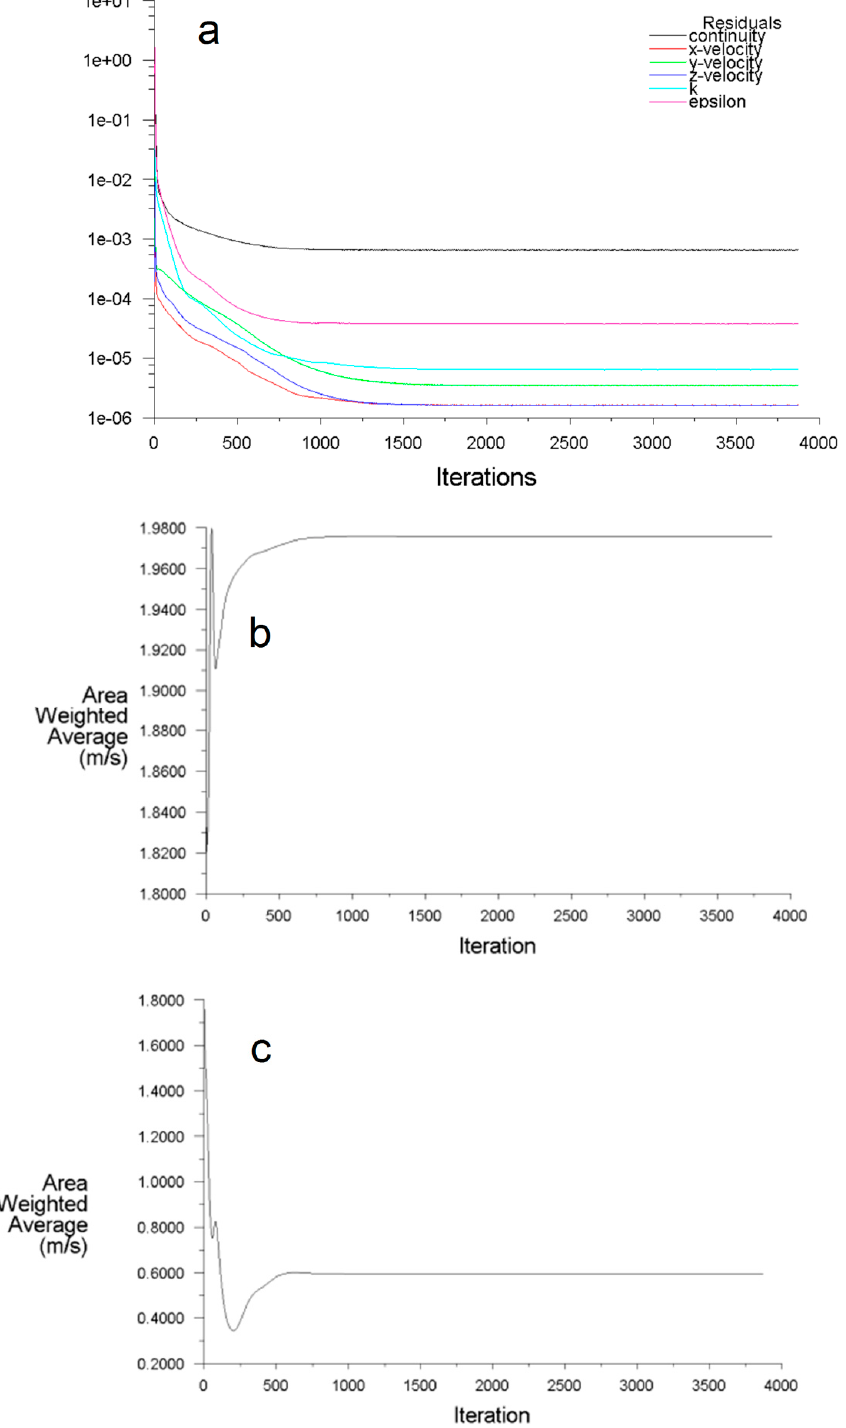
Figure 6. ( a ) FLUENT solution residuals and monitoring of convergence for ( b ) velocity at 9 m; and ( c ) velocity at 3 m.